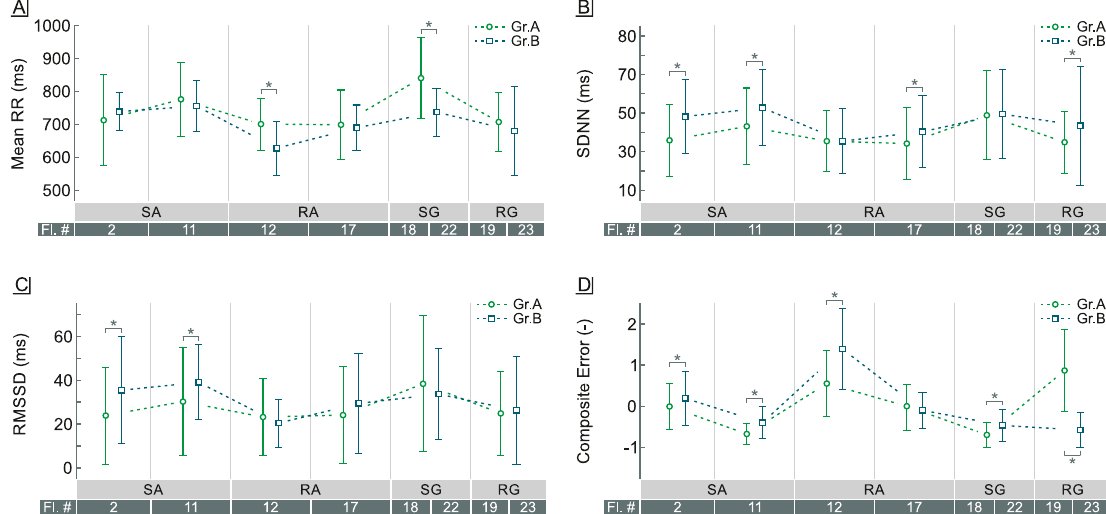
Figure 3. Mean RR ( A ), standard deviation of NN intervals (SDNN) ( B ), root mean square of successive RR interval differences (RMSSD) ( C ) and composite Error ( D ) distribution with no additional training for glass-cockpit (Gr. A) and with additional training for glass-cockpit (Gr. B). (S—simulated flight, R—real flight, A—analog cockpit, G—glass cockpit, Fl. #—flight number, *—significant difference between